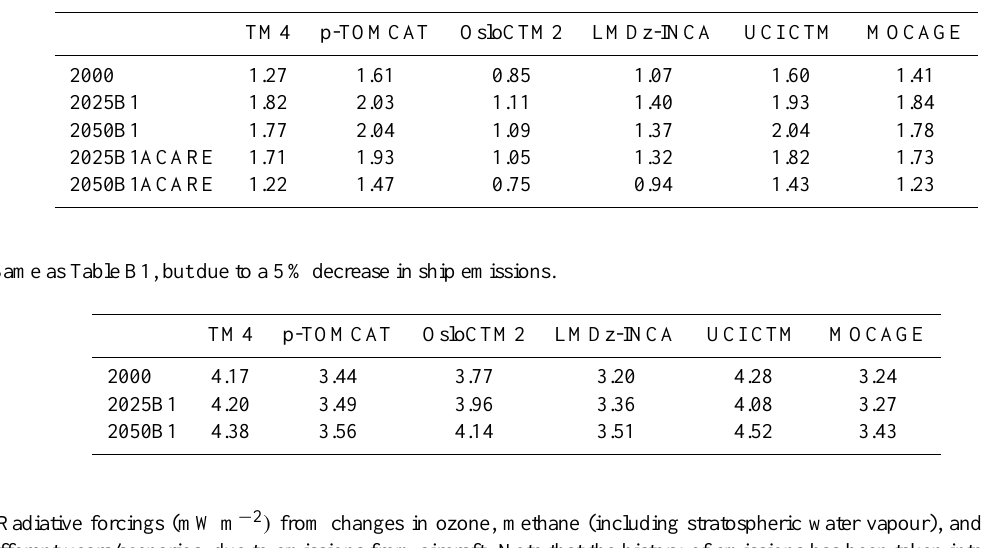
Table B1. Relative changes (%) in methane lifetimes (integrated up to 50hPa) due to a 5% decrease in aircraft emissions. Values are given relative to the BASE case, and are scaled to 100% by multiplying with 20. Note that this table does not include the feedback effect of methane changes on its own lifetime.